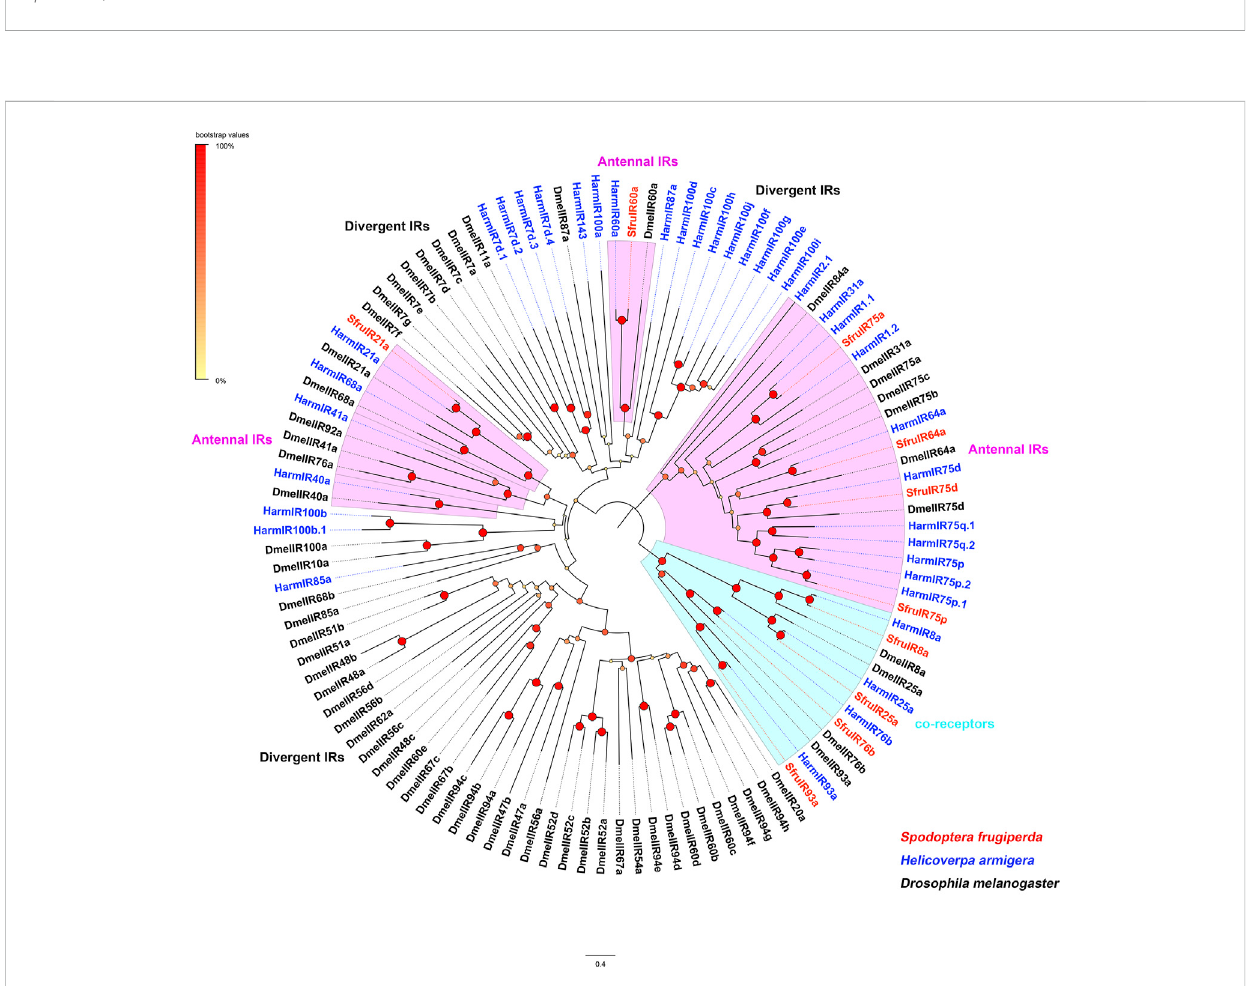
FIGURE 7 Phylogenetic analysis of the candidate SfruIRs from the transcriptome of S . frugiperda tarsi and IRs from H . armigera and D . melanogaster .